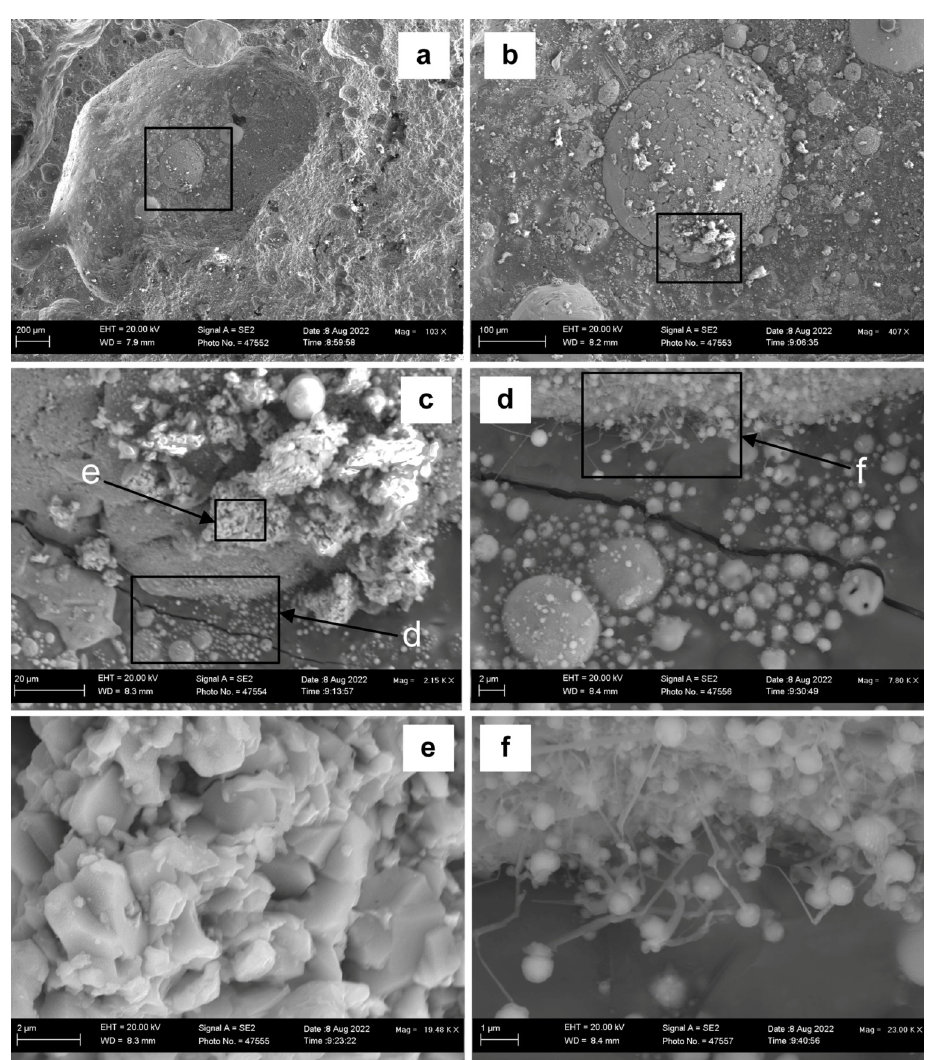
Figure 6. BSE image of dome in MP4 slag sample: ( a ) at 103 × magnification; ( b ) at 407 × magnification; ( c ) at 2150 × magnification; ( d ) at 7800 × magnification; ( e ) at 19,480 × magnification; ( f ) at 23,000 ×